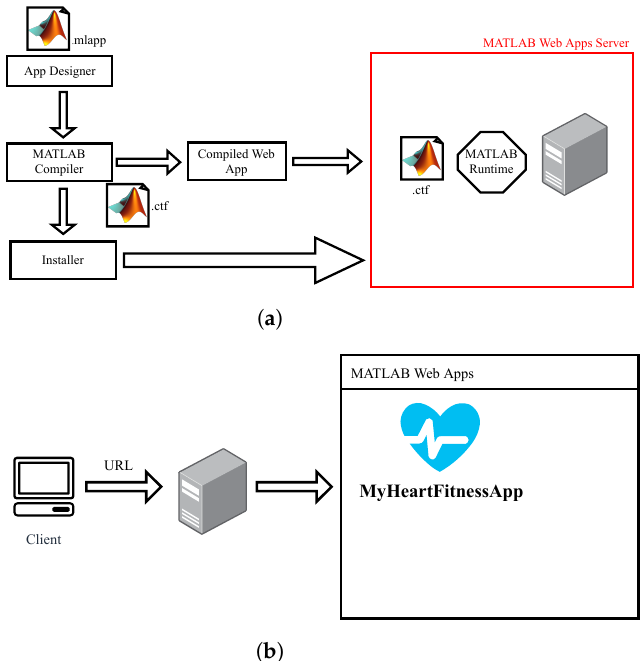
Figure A1. Functional diagram of the application implemented in MATLAB ( a ). Remote access to the developed application in the cloud ( b